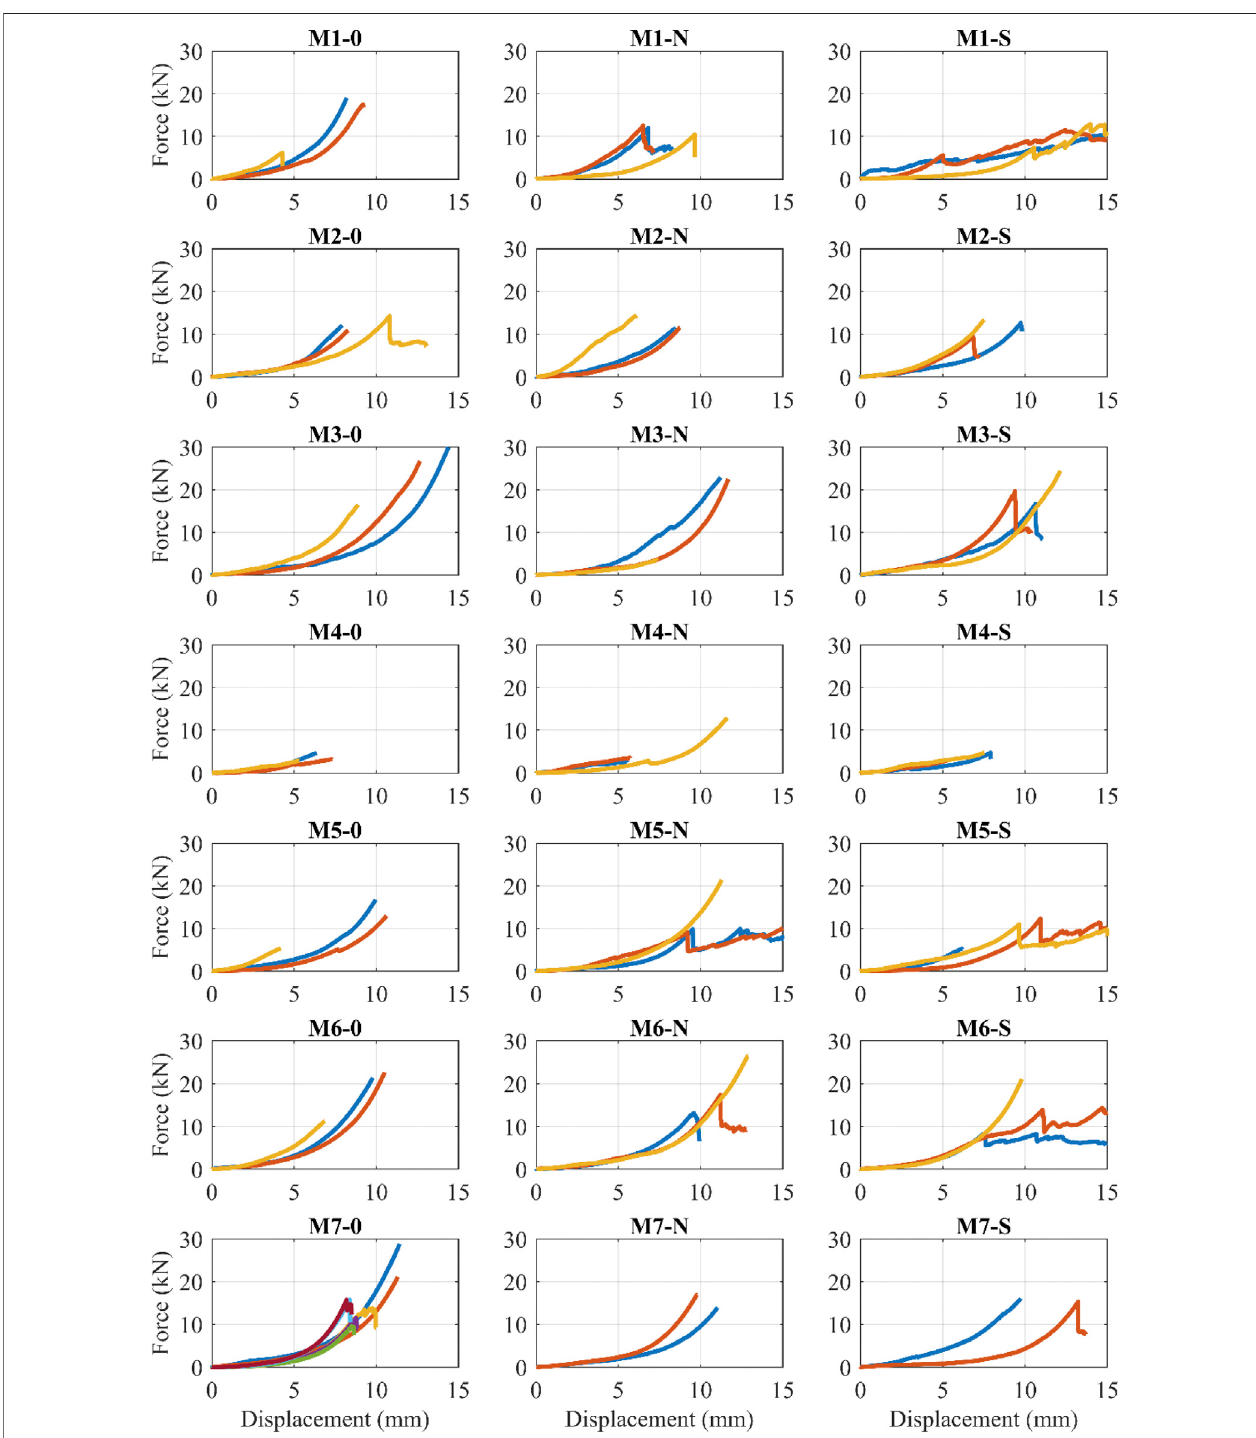
FIGURE 3 | Compression tests of the TBI using different mixes, screws and nails.